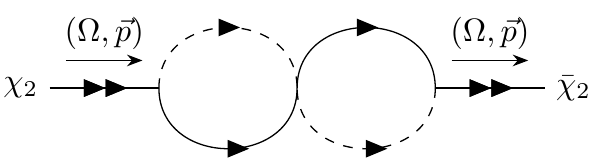
Figure 20. Two-loop correction to the self-energy for the dynamical fermion in sector 2.